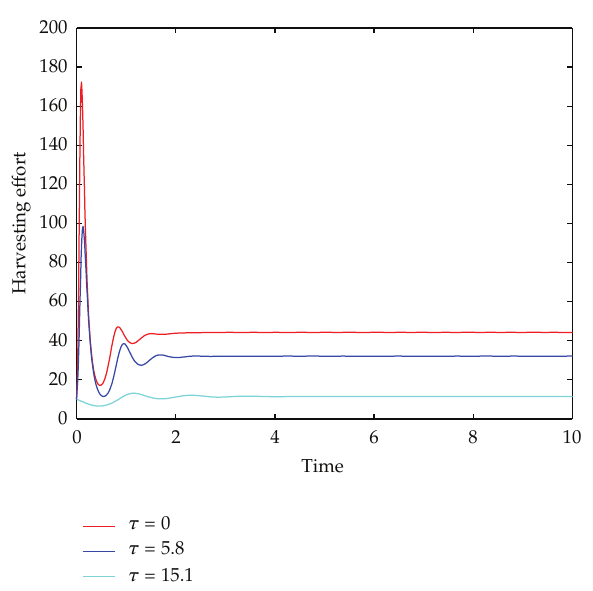
Figure 5: Variation of harvesting e ff ort with time for di ff erent tax levels.